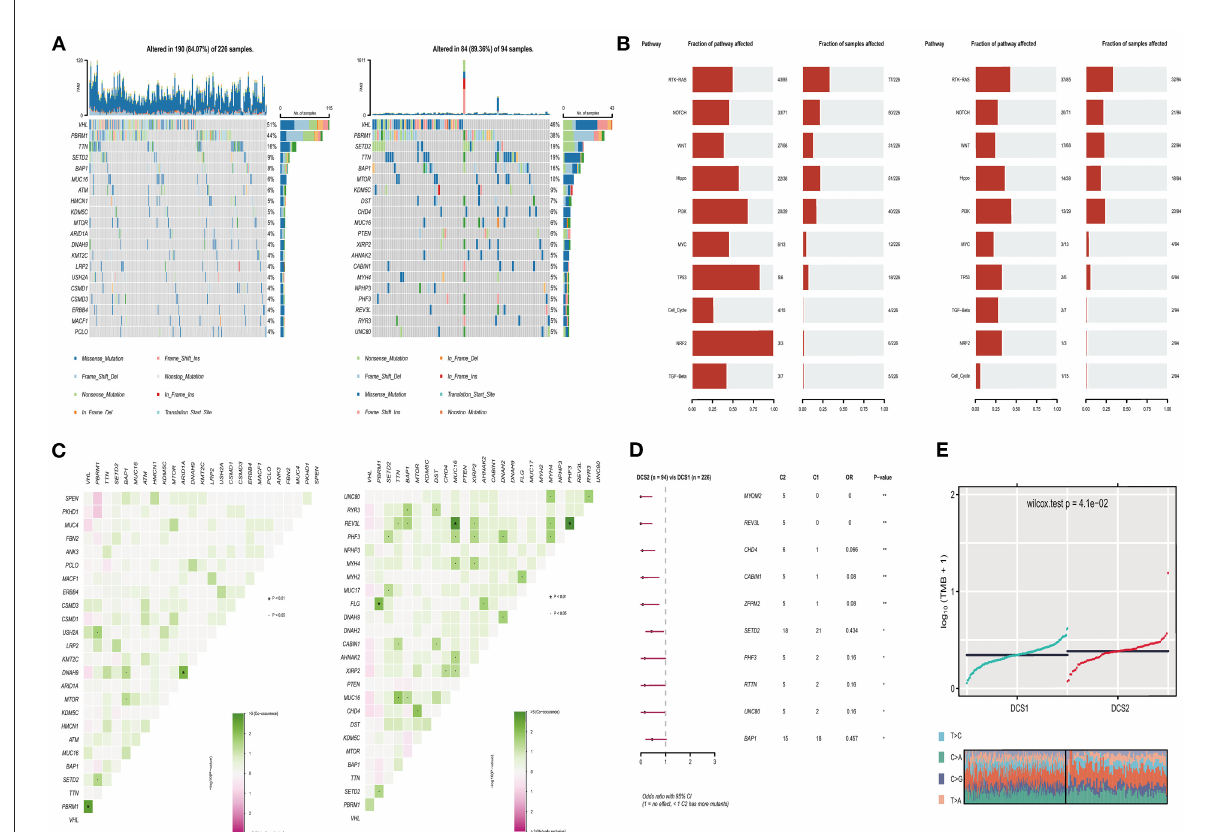
FIGURE5 Profiles of somatic mutations between the two subtypes. (A) Mutation landscape of DCS1 and DCS2, containing the top 20 mutated signatures. (B) Oncogenic signaling pathways in DCS1 and DCS2. (C) Co-mutation and -existing mutation pattern in DCS1 and DCS2. (D) Forest plot showing prognostic impact of mutated signatures between subtypes. (E) Tumor mutation burden difference between subtypes.